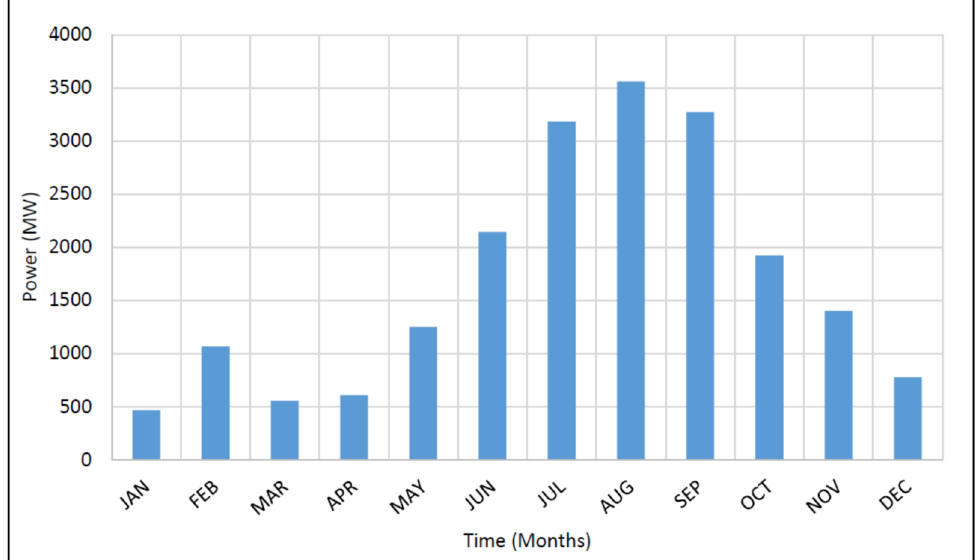
Figure 10. Mean Monthly Power generation pattern of Tarbela Reservoir (2008–2020).